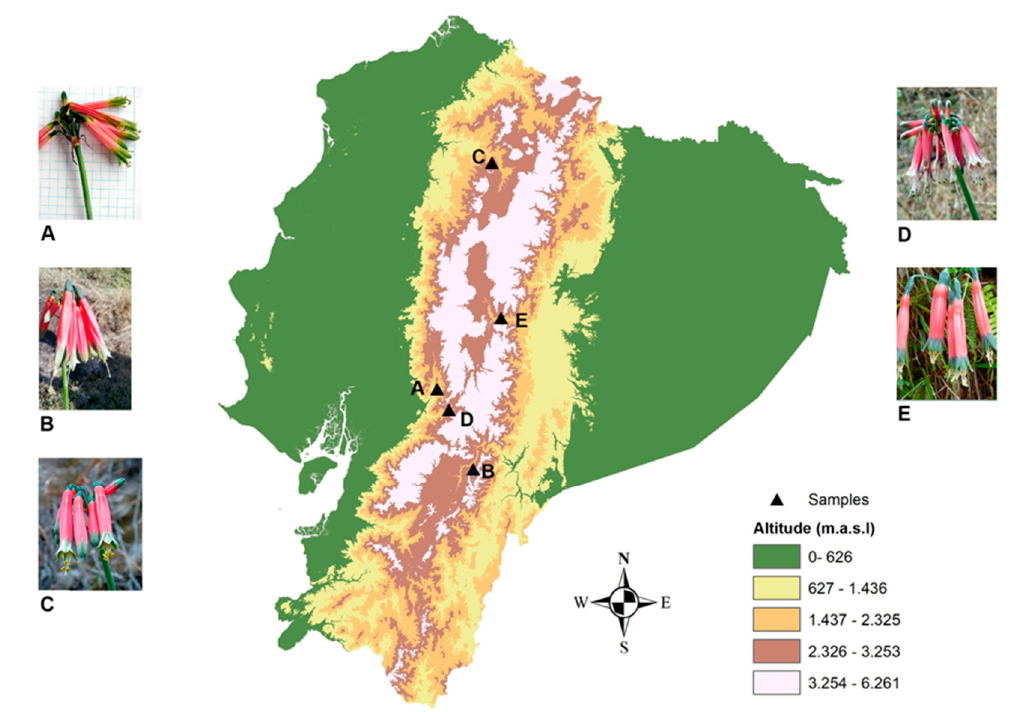
Figure 1. Distribution of Phaedranassa Herb. species in Ecuador. ( A ): P. cinerea ; ( B ): P. cuencana ; ( C ): P. dubia ; ( D ): P. glauciflora ; ( E ): P. tunguraguae .